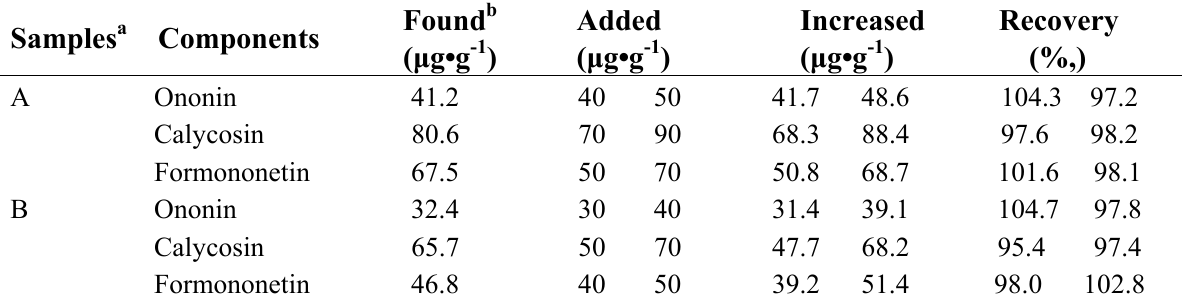
Table 4. Determination results of the three active components in A. mongholicus and A.